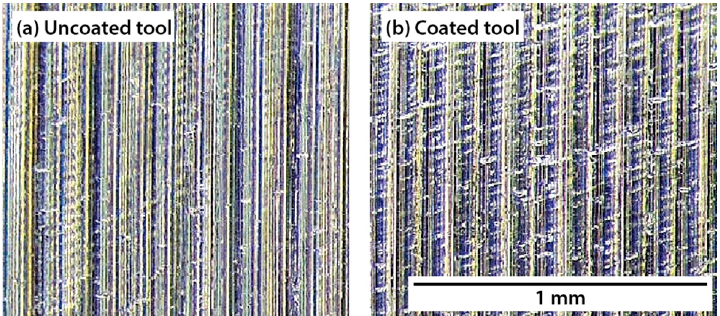
Figure 13. Machined surfaces with the ( a ) uncoated and ( b ) coated tool for configuration 3 at 50 m/min. Table 5. Values of the factors used in the ANOVA analysis.